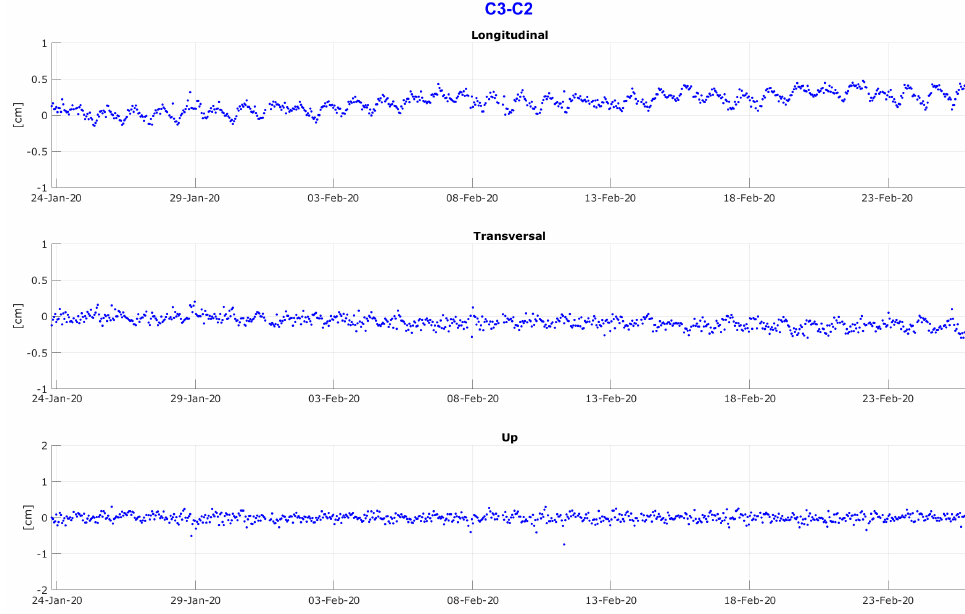
Figure 8. Hourly positions for C3–C2